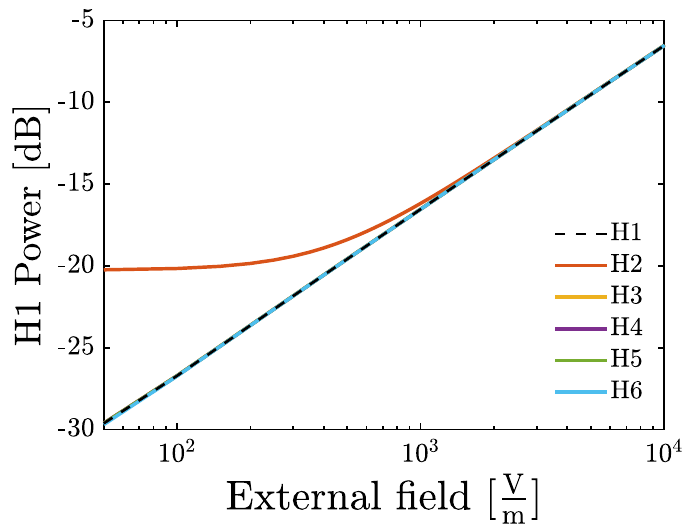
Figure 19. Impact of the first 5 spurious harmonics on the measurement accuracy compared to the fundamental harmonic. The amplitude of each harmonics was 1% of the fundamental frequency